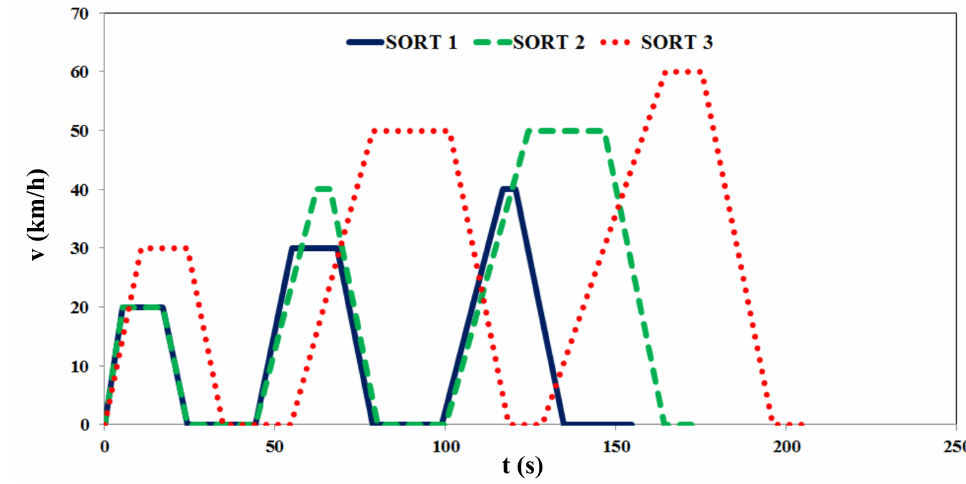
Figure 3. SORT 1, 2 and 3 driving